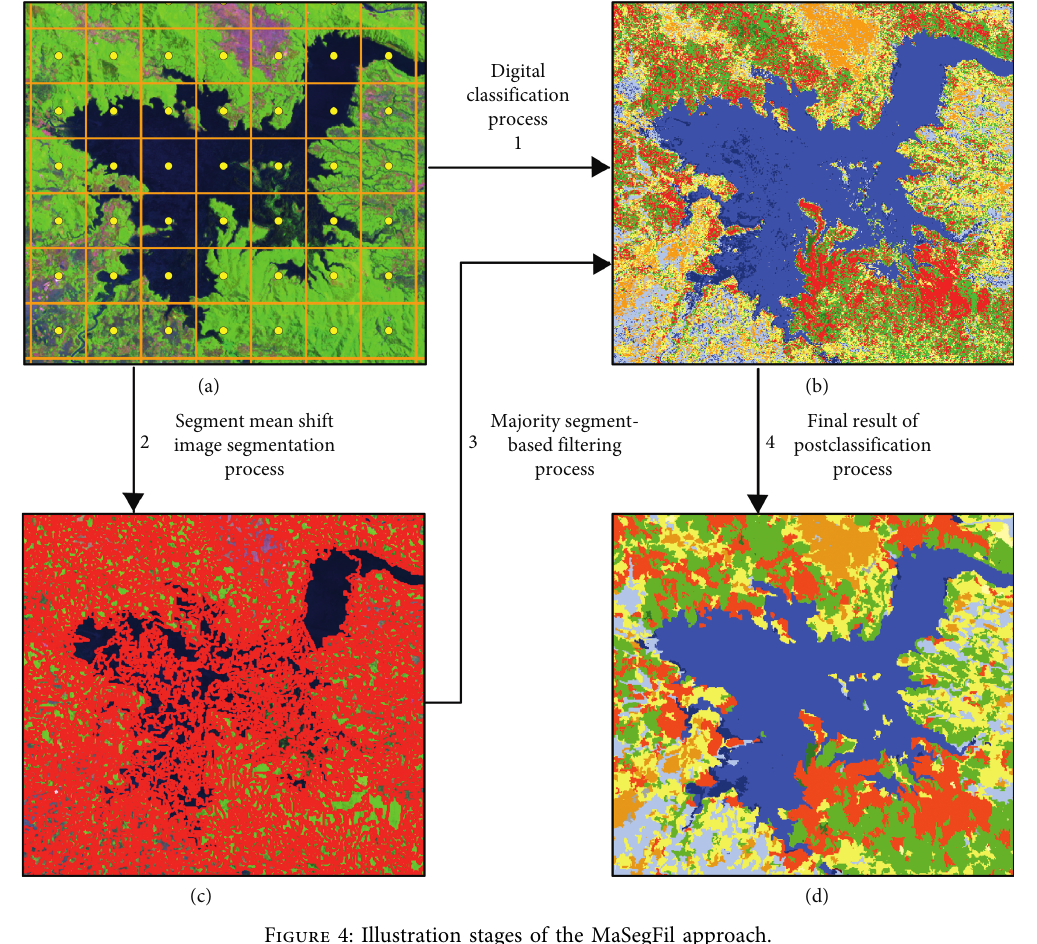
Figure 4: Illustration stages of the MaSegFil approach.